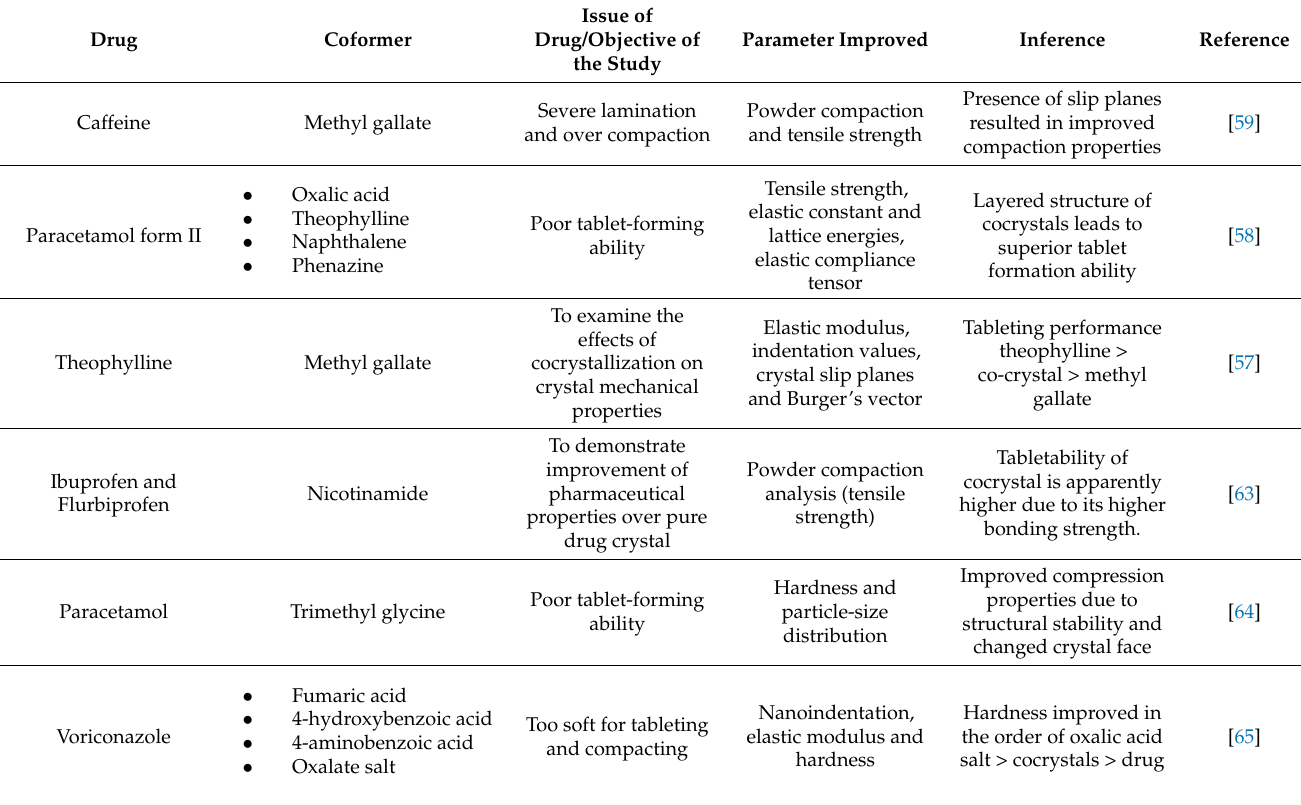
Table 2. Examples of studies reported on mechanical properties of drug molecules in